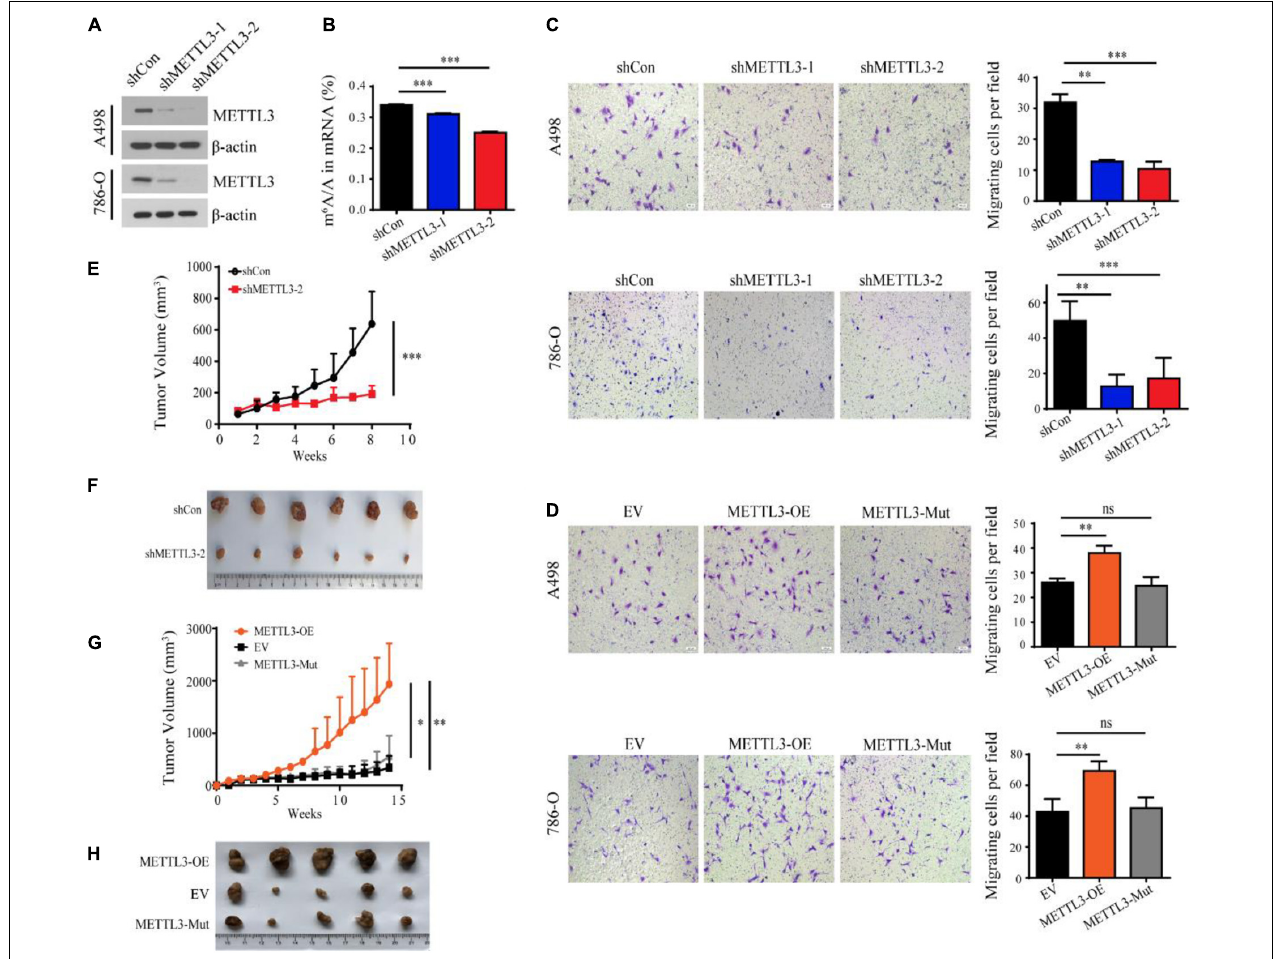
FIGURE 2 | METTL3 promotes ccRCC progression in an m 6 A methyltransferase-dependent manner. (A) Western blot of METTL3 in A498 and 786-O cells transduced with lentiviruses expressing scrambled short hairpin RNA (shCon) and two independent shRNAs targeting METTL3 (shMETTL3-1 and shMETTL3-2). β -actin was used as a loading control. (B) m 6 A ratio determined by LC-MS/MS in the control and METTL3 knockdown A498 cells. Error bars represent the standard deviation (SD) of three biological replicates. (C,D) Transwell assays of A498 and 786-O cells transduced with shRNAs targeting METTL3 (C) and METTL3-overexpressing virus (D) and quantitatively analyzed (right) (scale bar, 500 µ m). EV, control empty virus; METTL3-OE, METTL3-expressing virus; METTL3-Mut, methyltransferase inactivated METTL3-expressing virus. Error bars represent the SD of the mean ( n = 5). (E) Growth curves of xenograft tumors derived from shCon or shMETTL3-2 A498 cells. (F) Xenograft tumors formed by shCon or shMETTL3-2 A498 cells in nude mice. (G) Growth curves of xenograft tumors derived from A498 cells transduced with METTL3-expressing virus (METTL3-OE), METTL3-Mut-expressing virus (METTL3-Mut) and control empty virus (EV). Error bars represent the SD of the mean ( n = 5). (H) Xenograft tumors formed by METTL3-OE, EV, or METTL3-Mut A498 cells in nude mice. * P < 0.05, ** P < 0.01, *** P < 0.001.